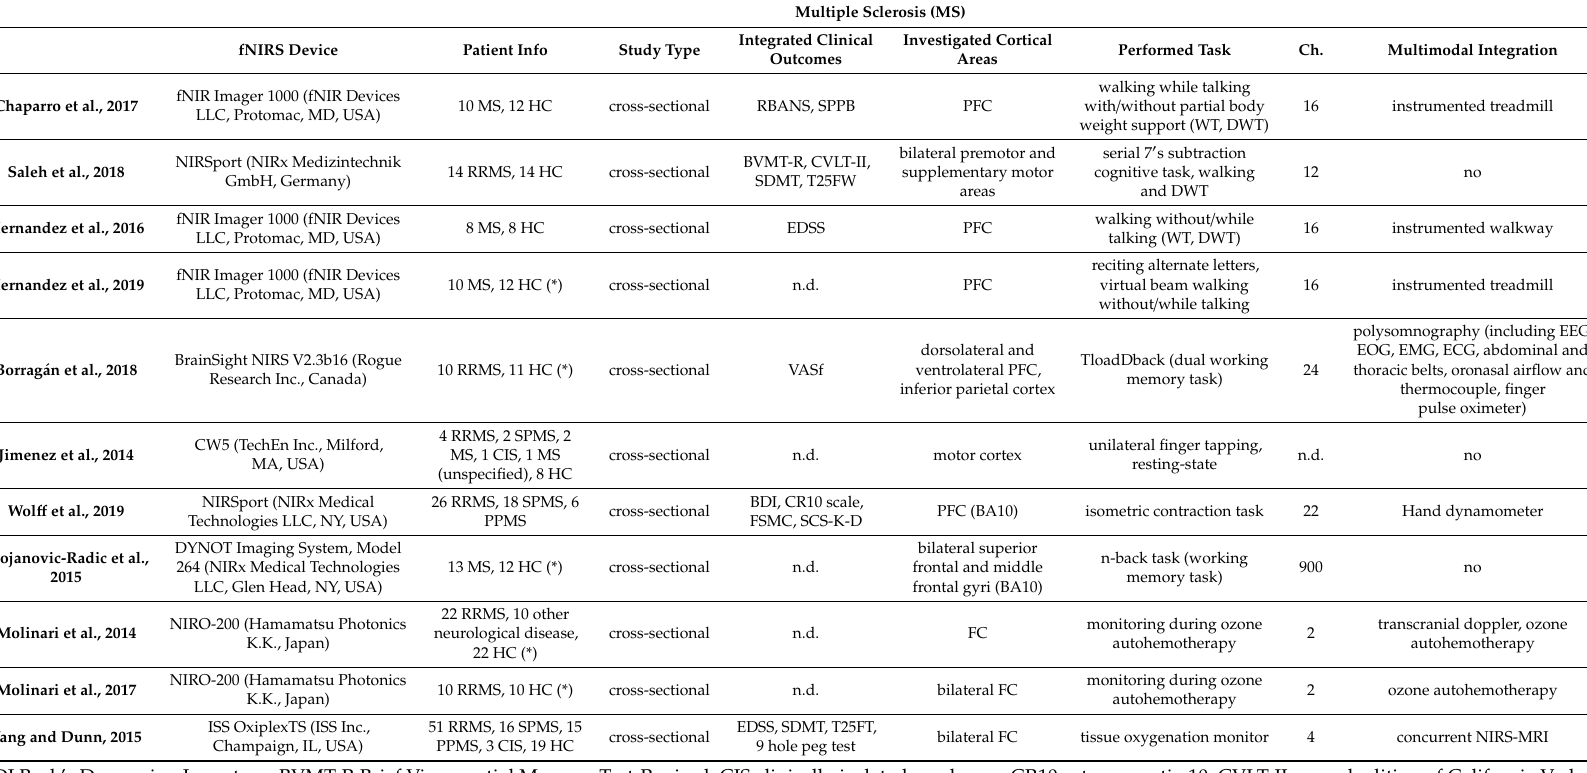
Table 3. Summary of peer-reviewed articles of fNIRS applications in Multiple Sclerosis (MS) patients found trough literature search of NCBI PubMed and Web of Science